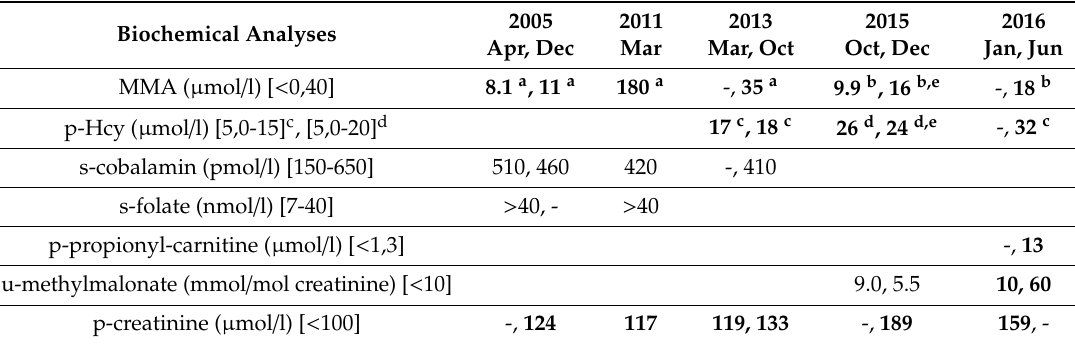
Table 1. Biochemical parameters reflecting status of the methionine cycle, renal function and mitochondrial metabolism with regard to methylmalonic acid (MMA). Chronic elevation of MMA is seen, together with mild MMA-uria and an associated elevation of p-propionyl-carnitine in 2016. Propionyl-carnitine was determined with a modification of the LC-MS-MS-method described by Ghoshal et al. [11], and u-methylmalonate by GC-MS-analysis of organic acids in urine [12]. Biochemical